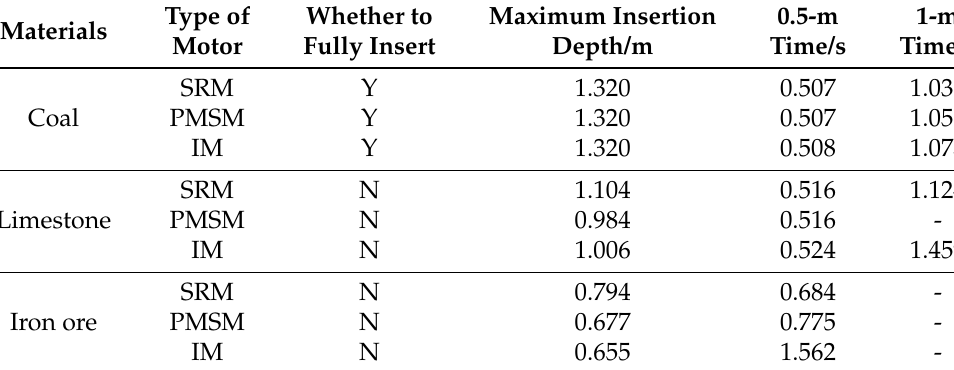
Table 6. Performance of three kinds of motor insert working condition.